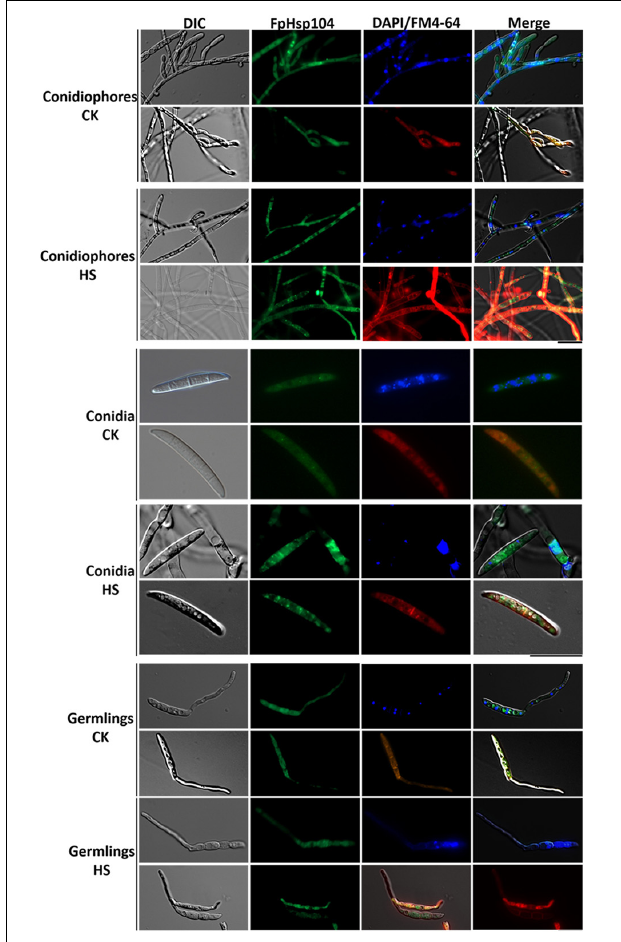
FIGURE 5 | Dynamic localization of FpHsp104 under heat shock. Micrographs showing the subcellular localizations of FpHsp104-GFP exposed to 34 ◦ C (HS) or not (CK). The conidiophores (top panel), conidia (middle panel), and conidia germination (bottom panel) are shown for each treatment. DAPI and FM4-64 staining were, respectively, used to visualize nuclear and vacuole regions. Green line, GFP fluorescence intensity; blue line, DAPI fluorescence intensity; red line, FM4-64 fluorescence intensity. Bar = 20 µ